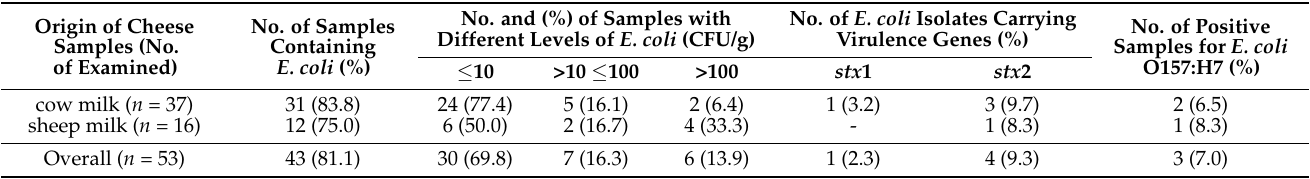
Table 1. Isolation and contamination level with E. coli of raw milk cheese assortments, and detection of virulence genes carrying isolates using molecular and immunological